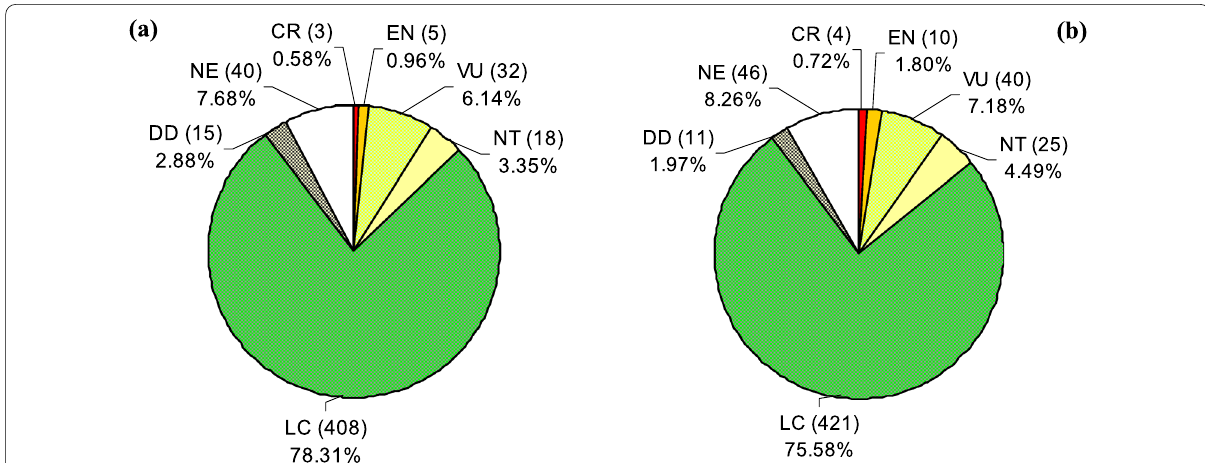
Fig. 2 Number and percentage of plant species in each IUCN Red List category of the Essiengbot‑Mbankoho ( a ) and Nbgwassa‑Opkweng ( b ) rural forests. The number of species is given in parentheses. IUCN Red List Categories: CR Critically Endangered, EN Endangered, VU Vulnerable, NT Near Threatened, LC Least Concern, DD Data Deficient, NE Not